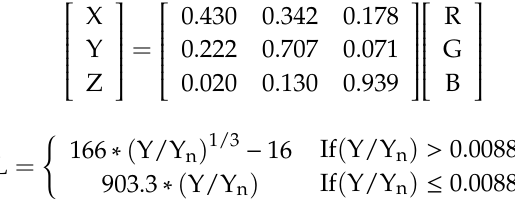
Figure 3. Flowchart of processing used in this paper.